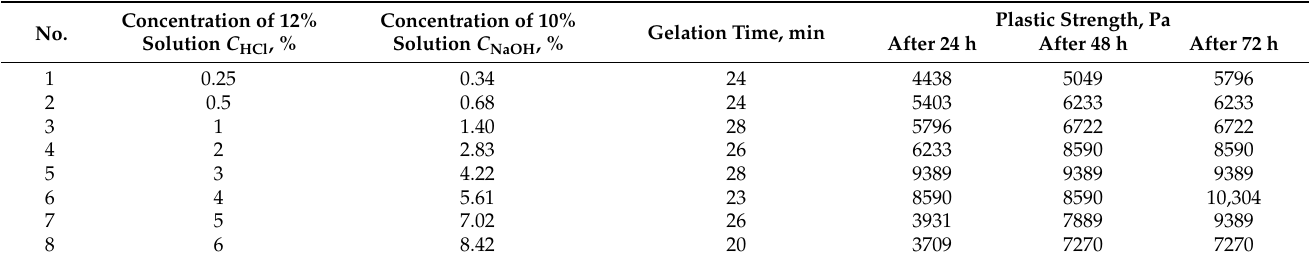
Table 3. Results of finding the plastic strength and the gelation time with the addition of a gelation delayer and a neutralizer to the polymer solution, based on the HPAN and chromium